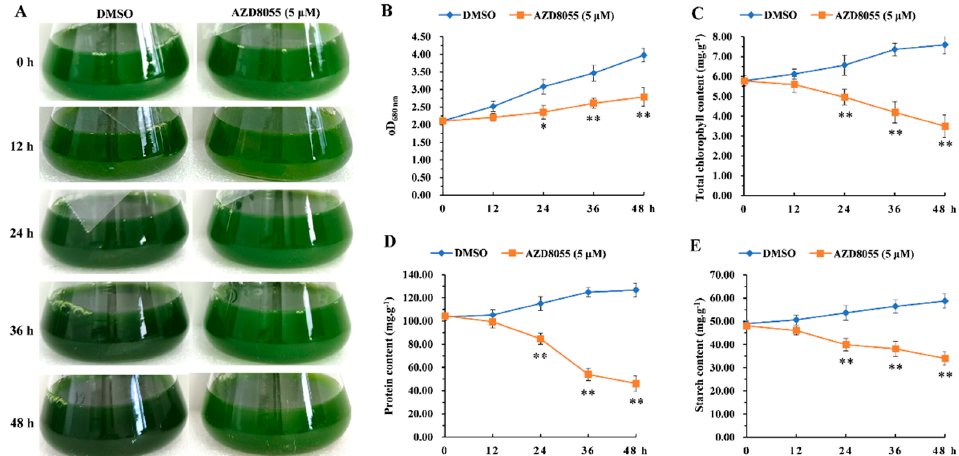
Figure 4. TOR regulates the biosynthesis of major intracellular substances in Auxenochlorella pyrenoidosa . ( A ) Phenotypes of A. pyrenoidosa treated with AZD8055 for 0, 12, 24, 36, and 48 h. A. a pyrenoidosa was cultured in 50 mL BG11 liquid medium for 4 days. Then, final-concentration 5 μ M AZD8055 or equivalent DMSO was added into the alga solution for 0, 12, 24, 36, and 48 h. ( B ) Change curves of OD680nm values of A. pyrenoidosa treated with 5 μ M AZD8055 for 0, 12, 24, 36, and 48 h. ( C ) Total chlorophyll content of A. pyrenoidosa treated with 5 μ M AZD8055 for 0, 12, 24, 36, and 48 h. ( D ) Protein content of A. pyrenoidosa treated with 5 μ M AZD8055 for 0, 12, 24, 36, and 48 h. ( E ) Starch content of A. pyrenoidosa treated with 5 μ M AZD8055 for 0, 12, 24, 36, and 48 h. Fresh weight of A. pyrenoidosa was used to measure chlorophyll, protein and starch contents, respectively. The data represents the mean ± SD of n = 3 independent experiments. Asterisks denote Student’s t -test significant difference compared with DMSO (* p < 0.05; ** p < 0.01).